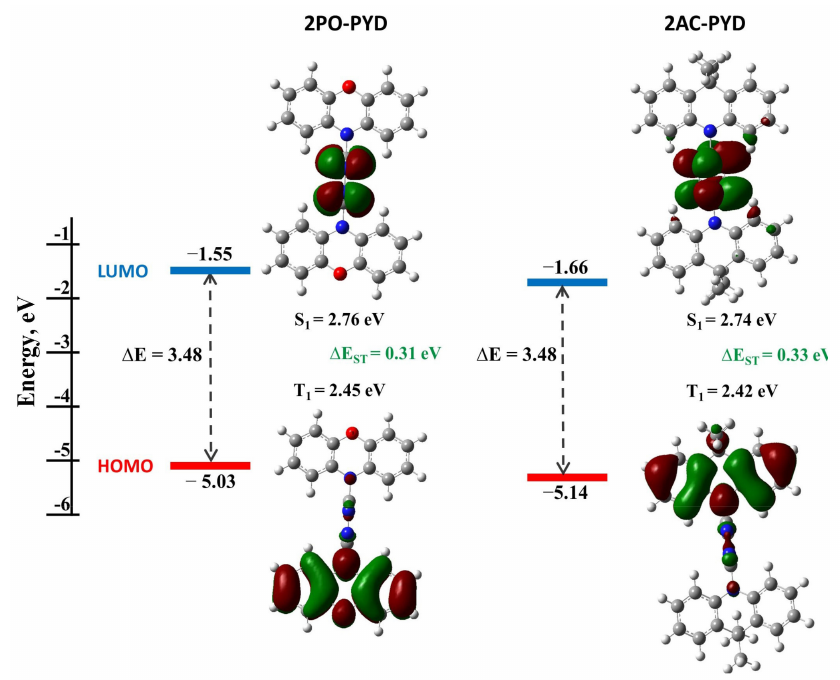
Figure 3. DFT calculated HOMO and LUMO energies, as well as HOMO and LUMO topologies (isovalue of 0.02), of compounds 2PO-PYD and 2AC-PYD